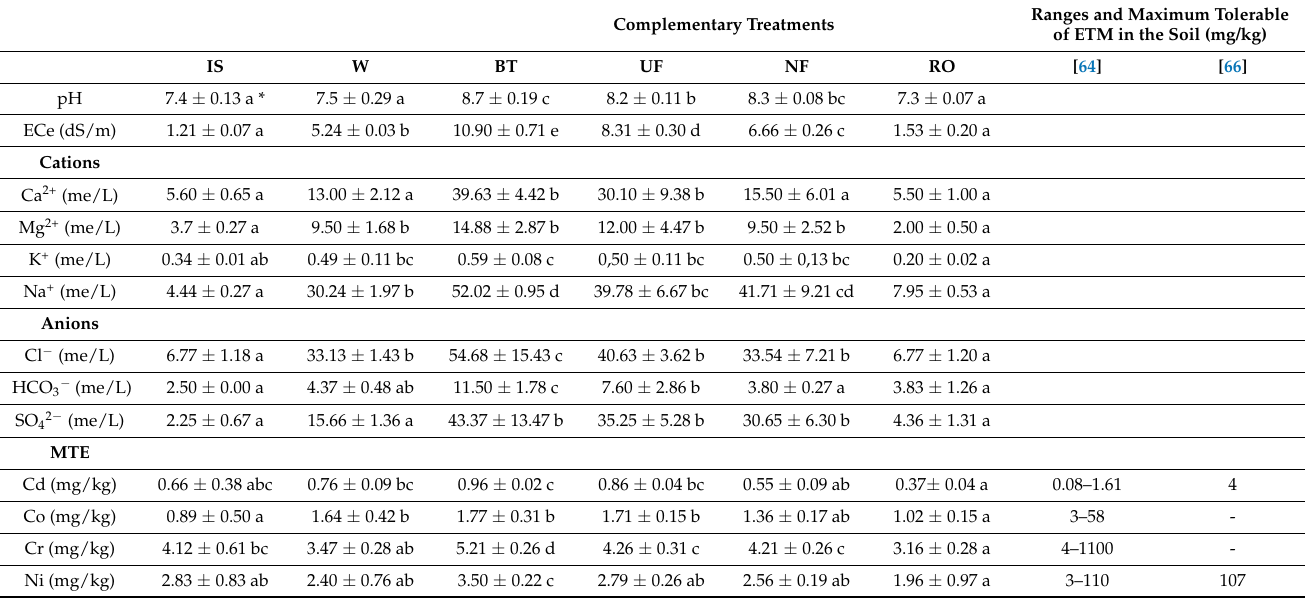
Table 3. Effects of irrigation by TTE on the soil. IS: Initial status; W: Well water; BT: Biological treatment; UF: Ultrafiltration; NF: Nanofiltration; and RO: Reverse Osmosis. Complementary Treatments Ranges and Maximum Tolerable of ETM in the Soil